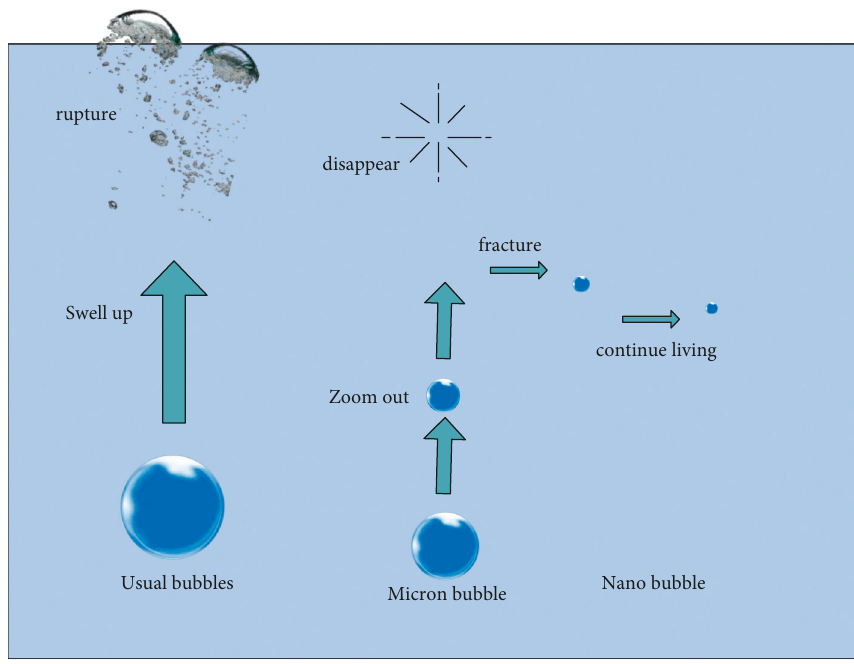
Figure 1: The change of bubbles of various diameters in the water.